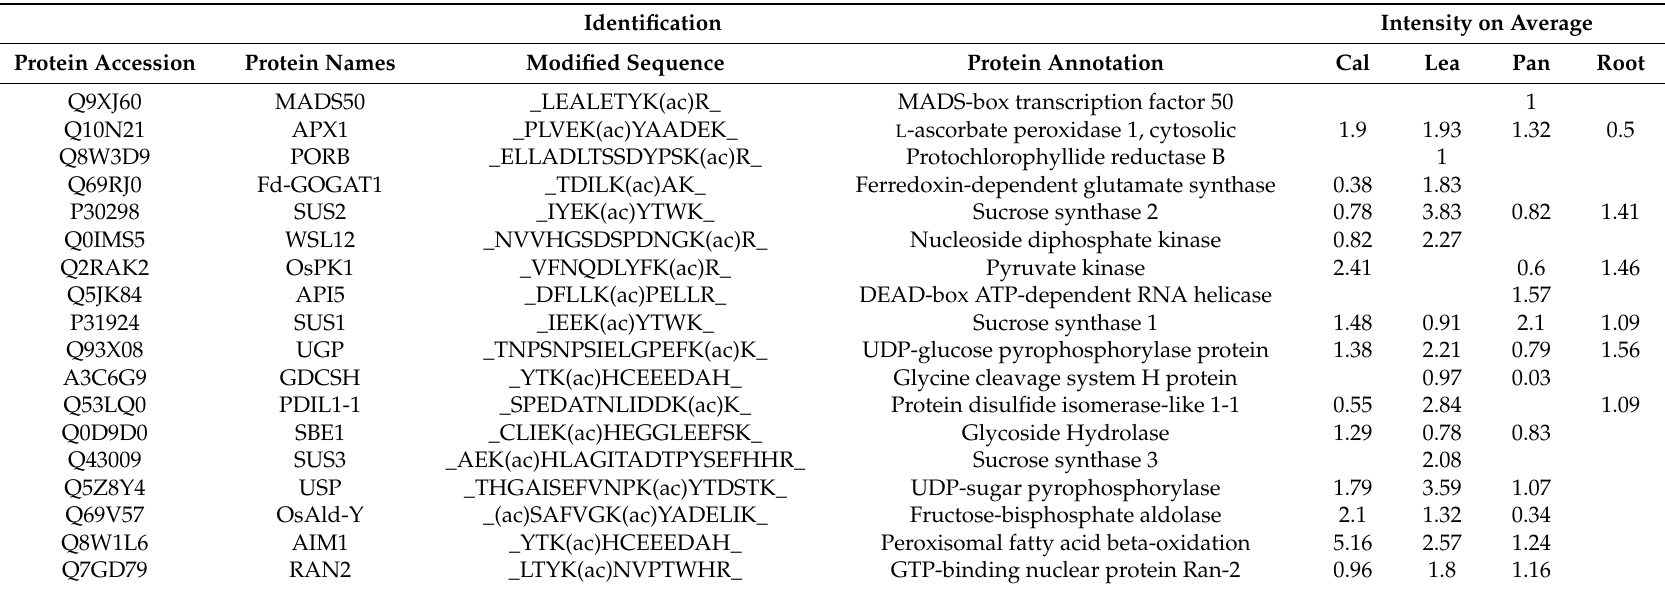
Table 1. Some of the selected examples of the identified